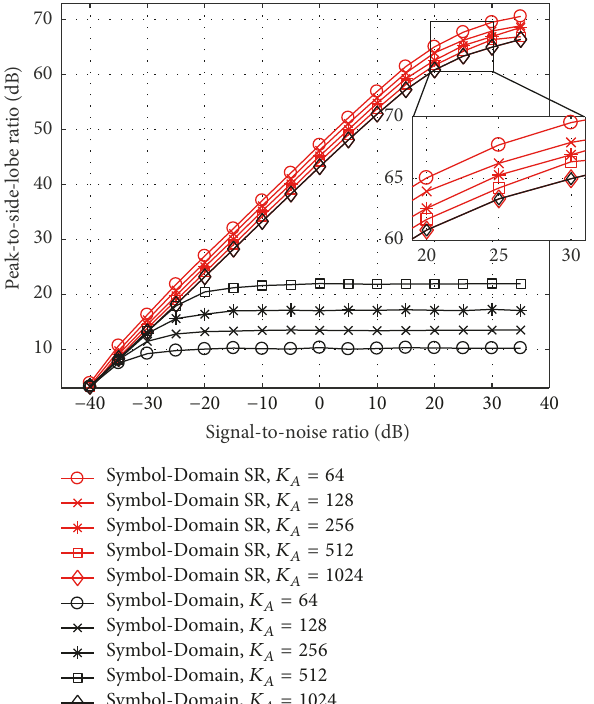
Figure 5: Achievable peak-to-side-lobe ratios of different methods in a noisy single user scenario.